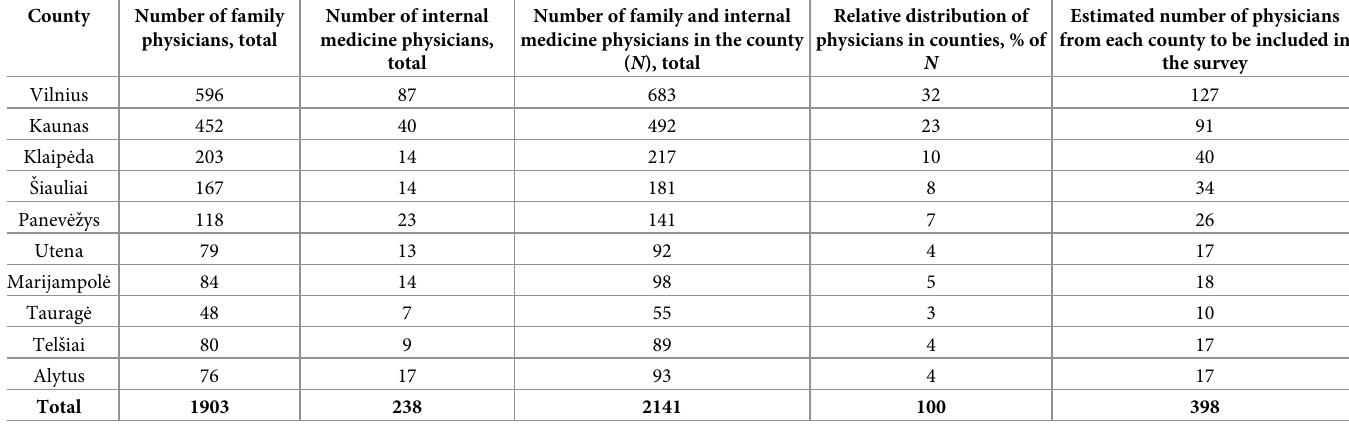
Table 1. The distribution of family and internal medicine physicians in Lithuanian